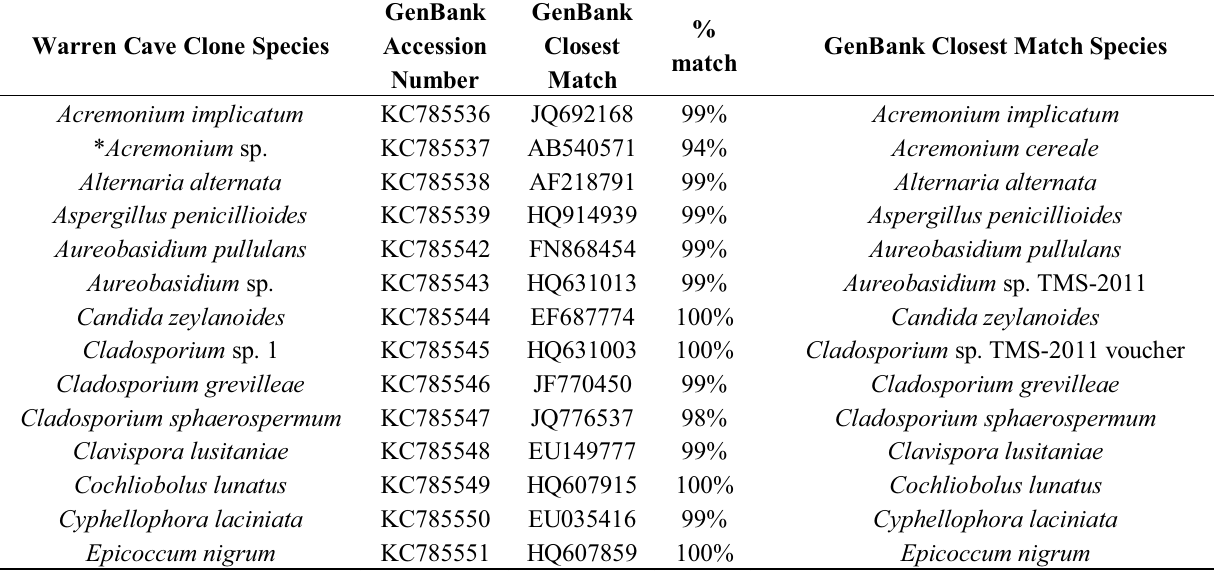
Table 1. Clones identified from Warren Cave with GenBank accession numbers and closest matches. Asterisks identify clones that fall below the 98% species identification